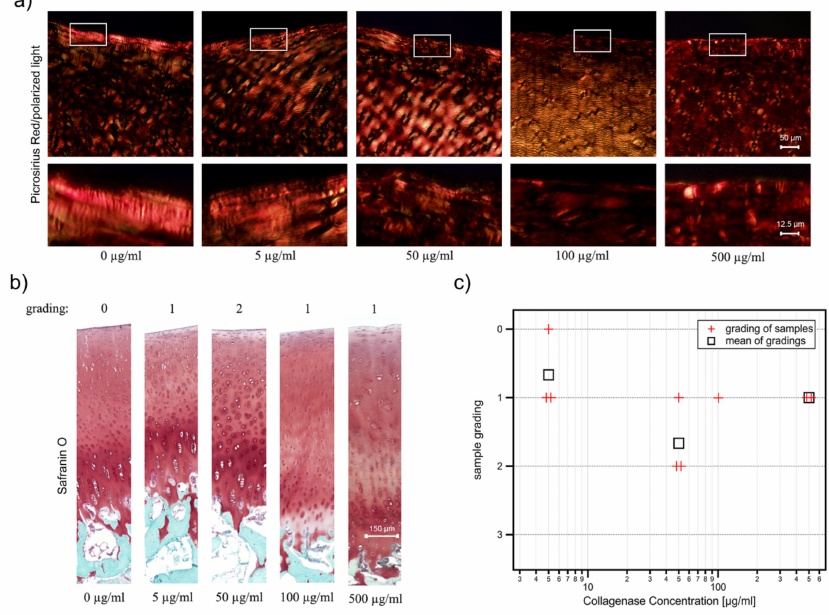
Figure 6. Summary of the histological findings of the measured bovine cartilage samples after the treatment with di ff erent concentrations of collagenase. In ( a ) representative images of Picrosirius Red staining of undigested and collagenase digested samples taken with polarized light. Rectangles indicate the magnified superficial zone of the articular cartilage. The collagenase concentrations are given in µ g / mL. In ( b ) representative images of the Safranin O / Fast Green stained sections of the average condition at di ff erent collagenase concentrations. In ( c ) the grades of all samples are summarized together with the mean values (black squares) per concentration, except for the concentration of 100 µ g / mL, where the result of only one sample is